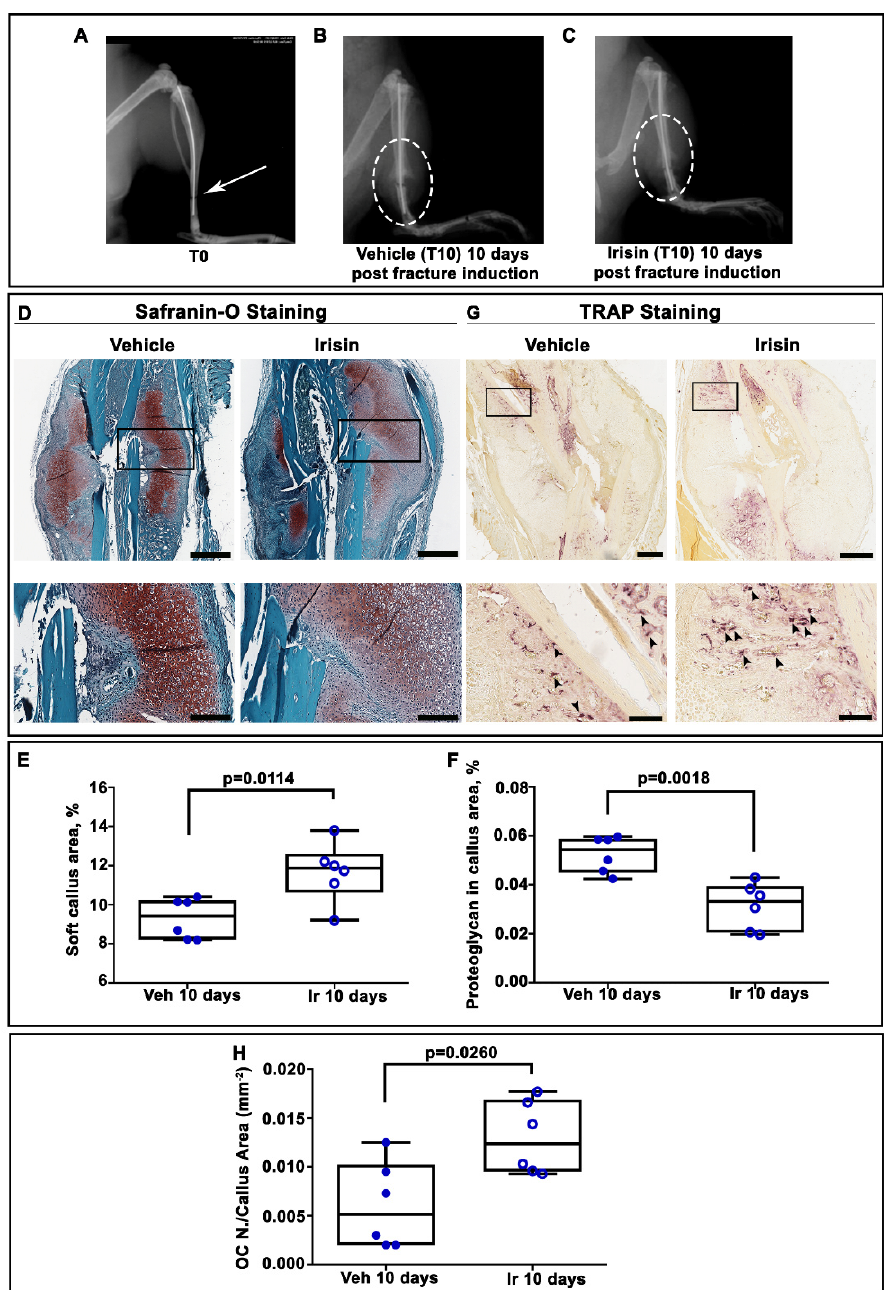
Figure 1. ( A ) Representative radiological images of fractured tibia at Time 0 (T0), and mice intermit- tently treated with ( B ) normal saline (vehicle) or ( C ) irisin at 10 days post-fracture. ( D ) Representative Safranin O-staining images of callus sections from vehicle- and irisin-treated mice at 10 days post-fracture (scale bar 0.8 mm). The black squares indicate the areas of higher magnification (scale bar: 60 µm). ( E ) Dot-plot graphs showing the increased soft callus area and ( F ) decreased proteoglycan-rich cartilage matrix in irisin-treated mice ( n = 6) compared with vehicle-treated mice ( n = 6). ( G ) Representative Trap staining images of callus sections from vehicle- ( n = 6) and irisin-treated ( n = 6) mice at 10 days post-fracture (scale bar: 0.8 mm). The black squares indicate the areas of higher magnification. ( H ) Dot-plot graph showing the significantly increased number of Trap-positive cells in the callus area (OC n . /CA) in irisin-treated mice ( n = 6) compared with vehicle-treated mice ( n = 6) (scale bar: 60 µ m). Data are presented as dot-plots with medians, from maximum to minimum, with all data points shown. The Mann–Whitney test was used to compare